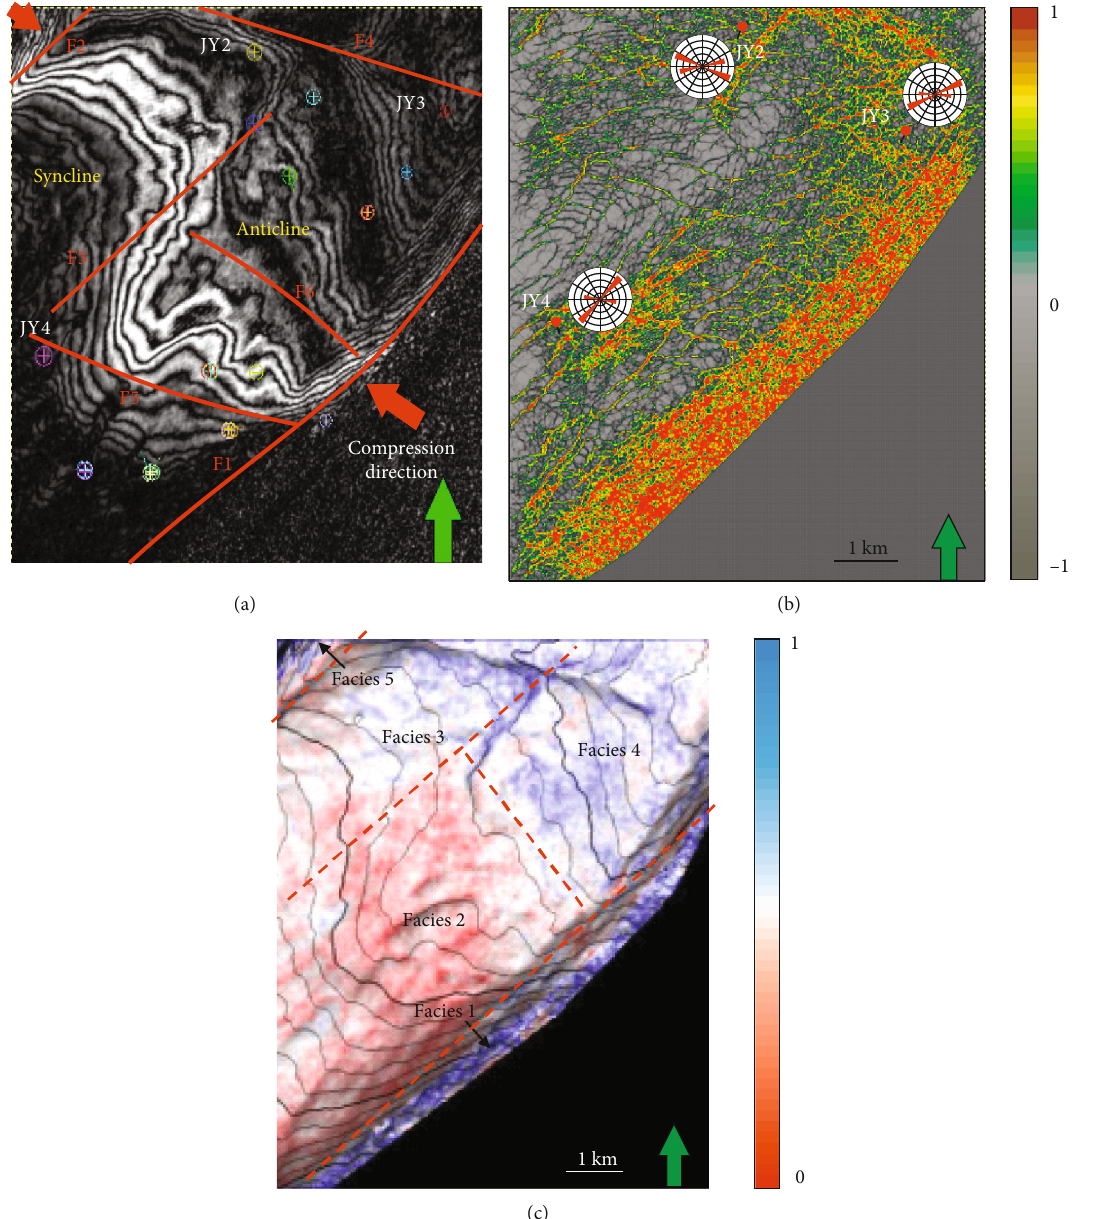
Figure 14: Analysis of structural deformation characteristics and fracture facies division in the study area. (a) Structural texture (TMR) inversion attribute, which shows the tectonic deformation characteristics and in situ stress properties of the shale in the study area. (b) Variance attribute, which can be transformed into fracture development intensity. Fracture facies were divided by fracture spreading direction and intensity. In areas where the natural fractures developed, for example, southwest, the average cumulative gas production volume is over 80 × 10 4 m 3 , whereas the numerical value is much lower where the fractures are not developed. It is indicated that the proper development of natural fractures has certain positive e ff ects on shale gas development. (c) Fracture facies division based on tectonic stress di ff erences in the study